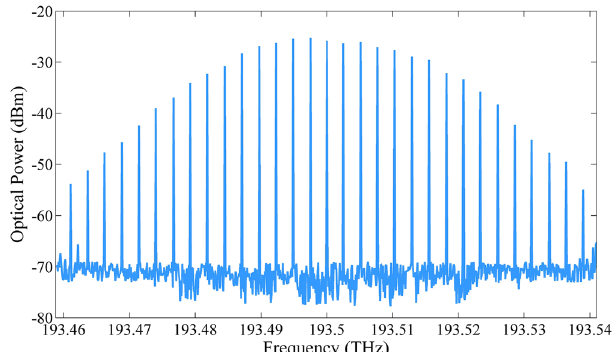
Figure 5. 2.6-GHz optical frequency comb at the PIC